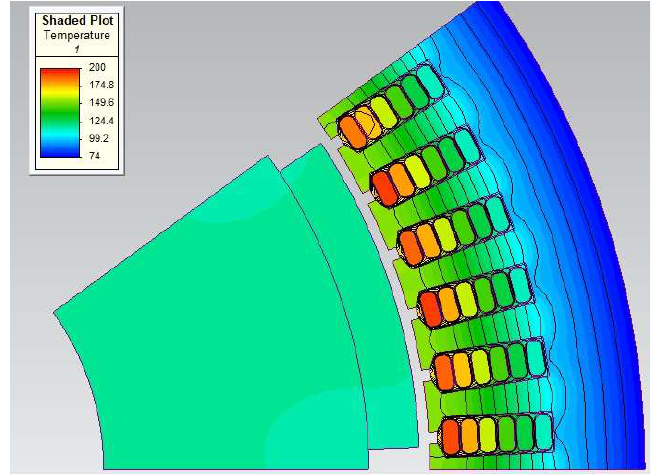
Figure 7. The FEA temperature map of the considered surface PMSM.